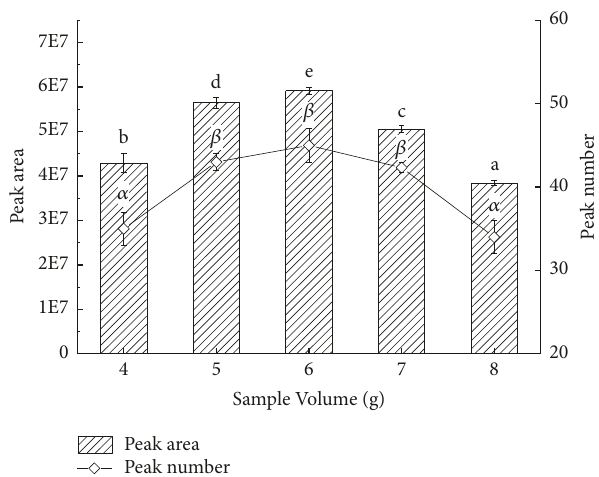
Figure 4: Effects of different sample volumes on extracting volatiles of pepper chicken soup. English letters “a”, “b”, “c”, “d”, “e” indicate Duncan’s multiple range test among peak areas of the five sample volumes. Greek letters “ 𝛼 ” and “ 𝛽 ” indicate Duncan’s multiple range test among peak numbers of the five sample volumes. Data in the same group marked with differentlettersmean significantdifference ( p < 0.05) and the same letters denote not significant difference (p <